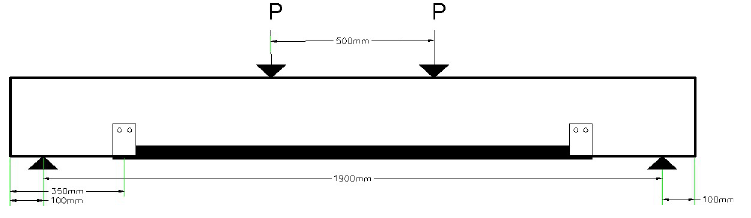
Fig 10. Beam 101 (101-F-2S0-1BW-2CFWNB-350).